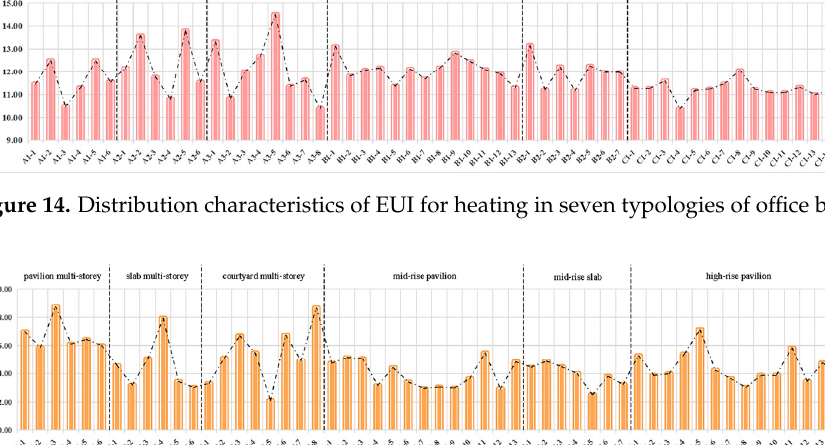
Figure 15. Distribution characteristics of EUI for lighting in seven typologies of office blocks.